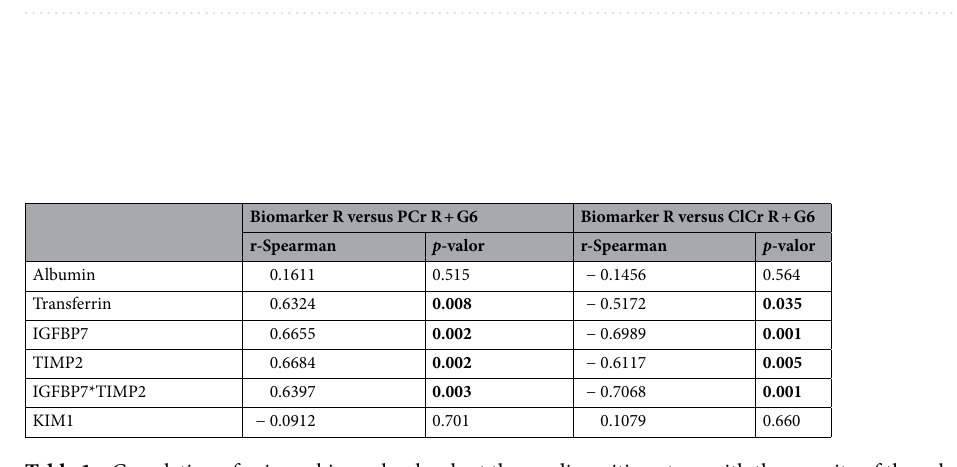
Figure 8. ROC curves showing predictive value of urinary biomarkers on increased susceptibility to new AKI. AUC area under the curve, CI confidence interval.